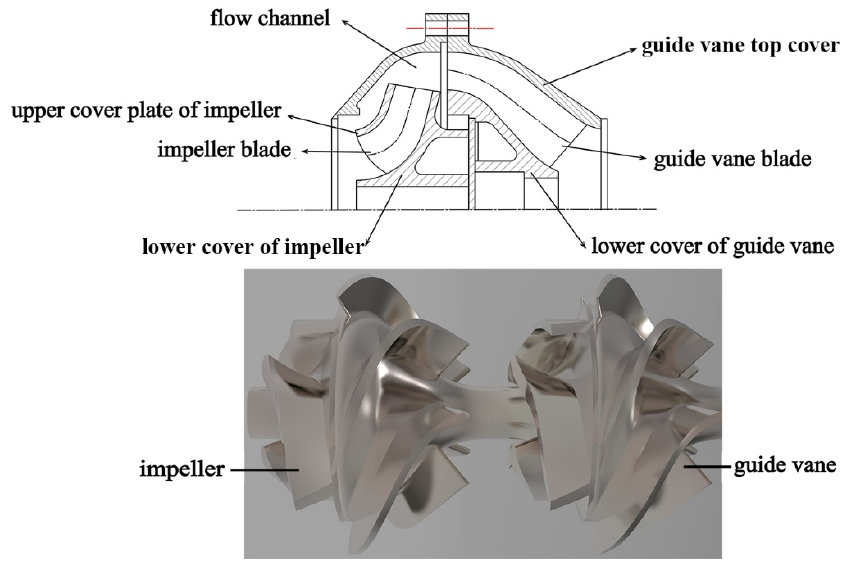
Figure 2. Deep-sea lifting electric pump structure.